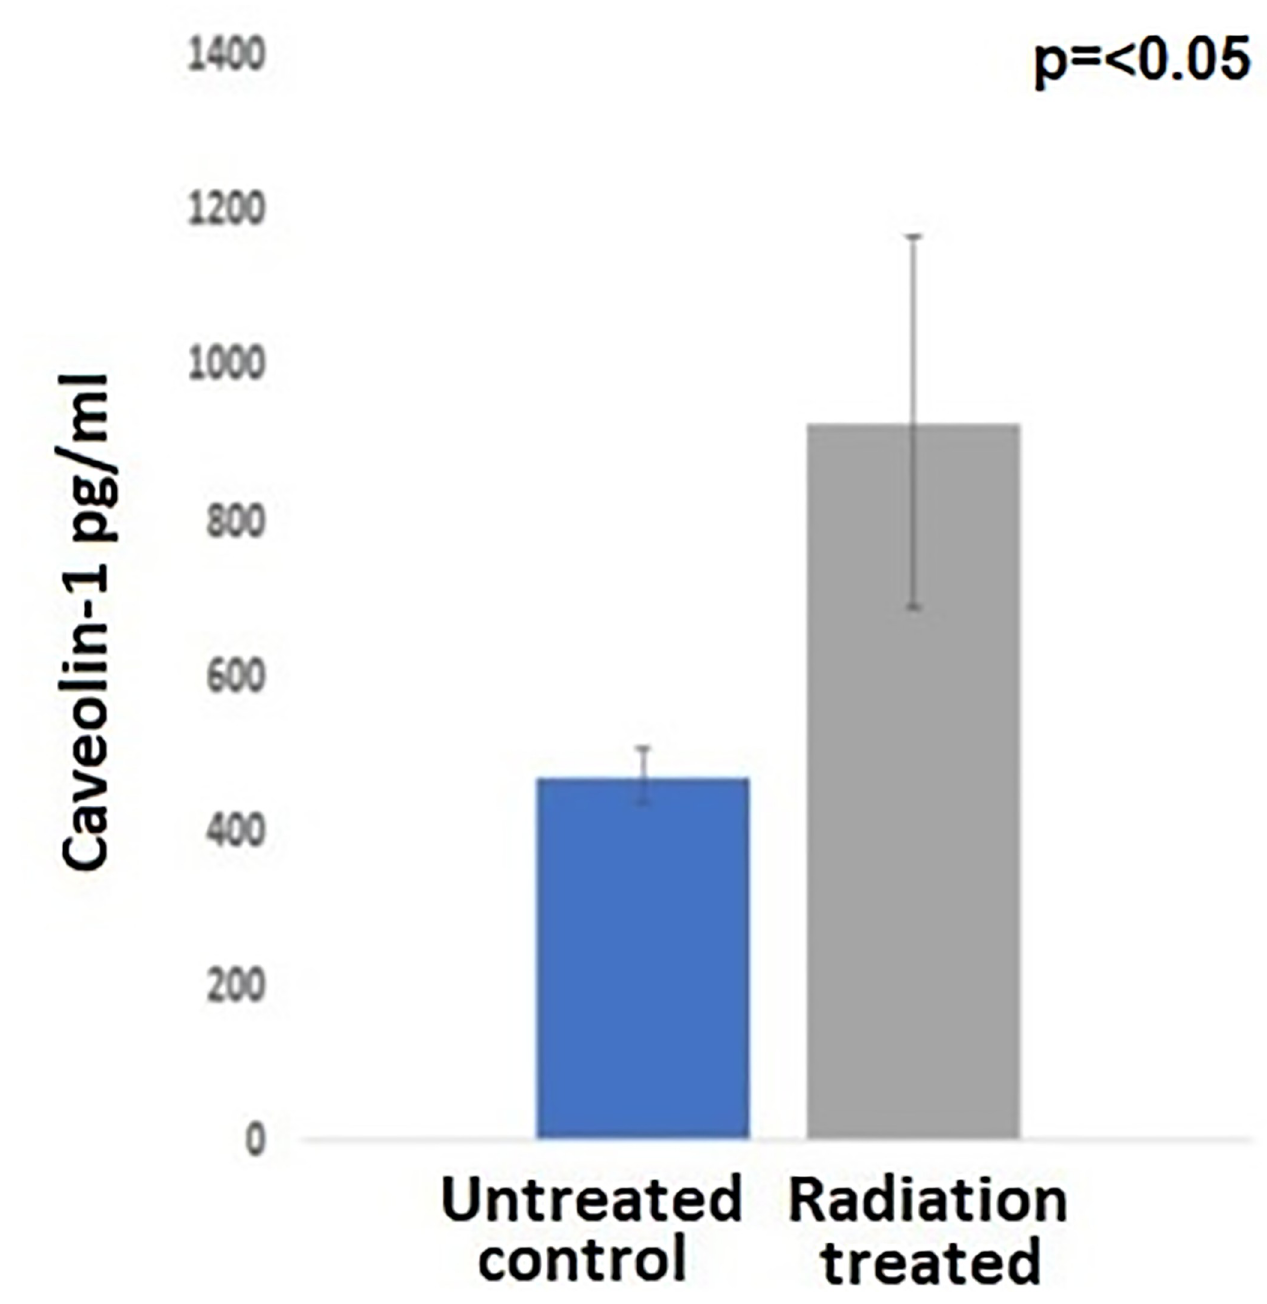
Fig 9. Optimization of ELISA assay in the blood of radiation treated, and untreated human lung cancer xenograft mouse model. https://doi.org/10.1371/journal.pone.0258951.g009 CAV-1 gene (Figs 6 and 7) [40, 41]. Importantly, these patients with CAV-1 alteration had worse prognosis, and significantly reduced progression free survival when compared with patients without CAV-1 gene alteration (Fig 8). An important clinical finding also reported ele- vated CAV-1 expression in 69 cases of brain metastasis from lung cancer (NSCLC), that insti- gated radioresistance and very poor outcome [42].Thus, TCGA clinical data clearly suggest that CAV-1 amplification is linked to copy number variation which is involved in altering